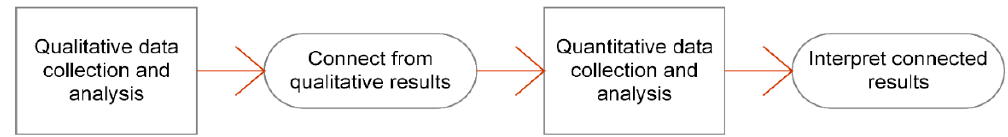
Figure 3. Exploratory sequential model followed as part of the survey design [33].